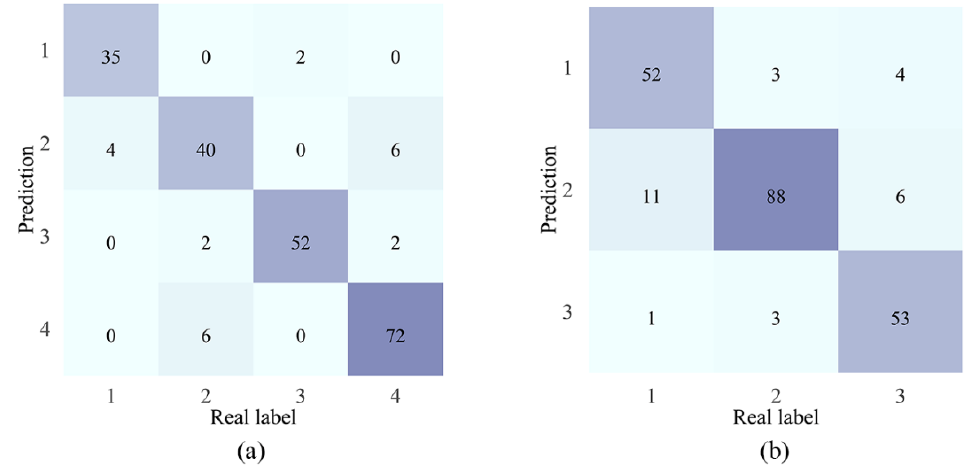
Figure 7. Two-stage model results of confusion matrix. (The text feature extraction method is Word2Vec, and the length of the text vector is 300.) ( a ) Stage of fault location. ( b ) Stage of troubleshooting mode selection.